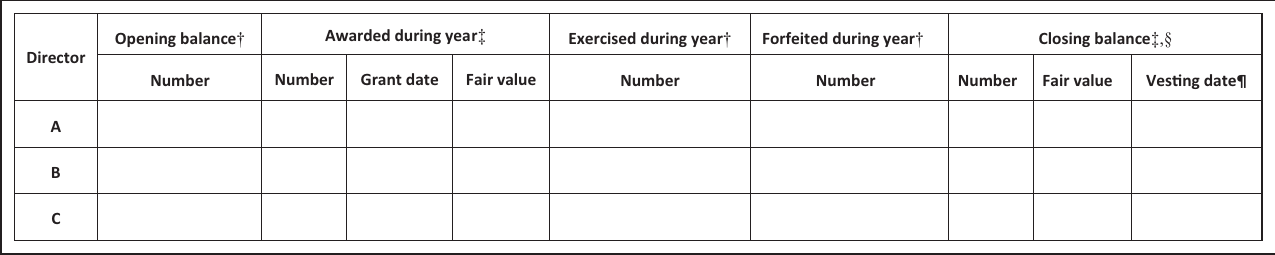
FIG URE 2: Best practices disclosure example: Instruments exercised during the